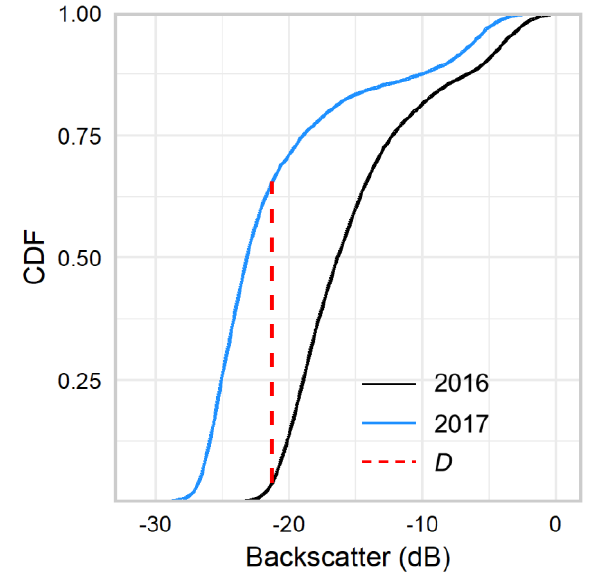
Figure 5. Cumulative distribution functions for Bedford Basin 200 kHz datasets at the test area, with D = 0.62.